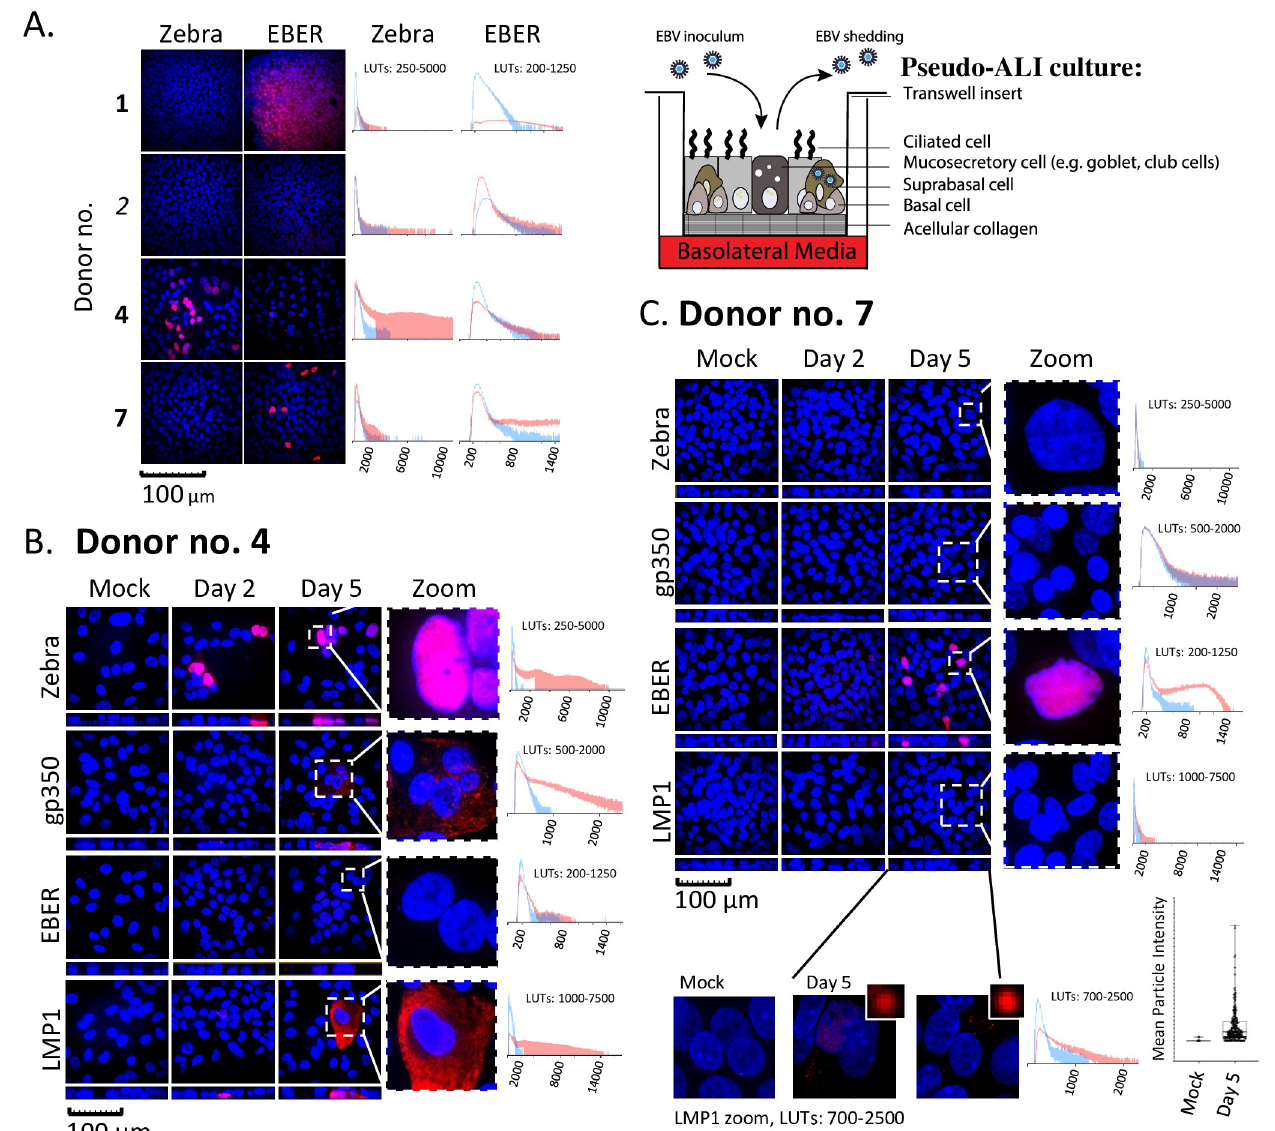
Fig 2. EBV de novo infection of primary nasopharynx-derived epithelial cells in pseudo-ALI culture. A-C, Immunofluorescence staining and EBER-ISH images (red) for EBV molecular diagnostics in pseudo-ALI cultures infected with EBV-positive rAkata B-cells or EBV-negative Akata B-cells (mock), counterstained with DAPI (blue). Shown are maximum intensity projections of confocal images on the xy (square) and xz (rectangle) planes. The pixel signal intensity of the EBV markers in the unzoomed image, in mock (blue line) and EBV-infected (red line) samples, are compared in the histograms. (A) Shown are the results for four donors. Cells were harvested at days 4–5 p.i. for Zebra and days 5–7 p.i. for EBER-ISH. More extensive analysis at days 2 and 5 p.i. was performed for donors (B) no. 4 and (C) no. 7. LMP1 foci in the weakly stained sample (donor no. 7) was also scored as mean particle intensity, from the unzoomed image. Bold, susceptible donor sample; italics, non-susceptible donor sample. LUTs, look-up-tables.